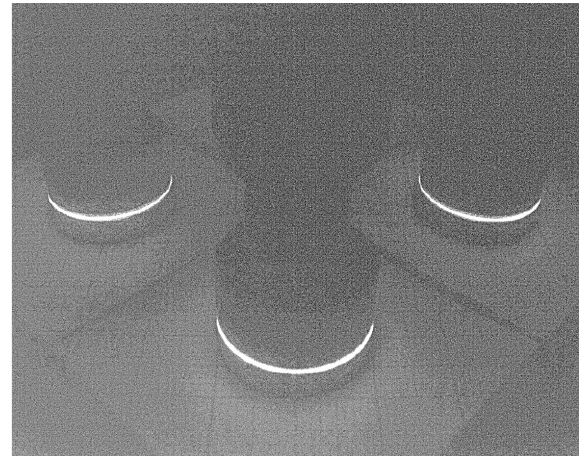
Figure 10: Plain plug gauge acquired by the LTS camera. Image adjusted for a better view.